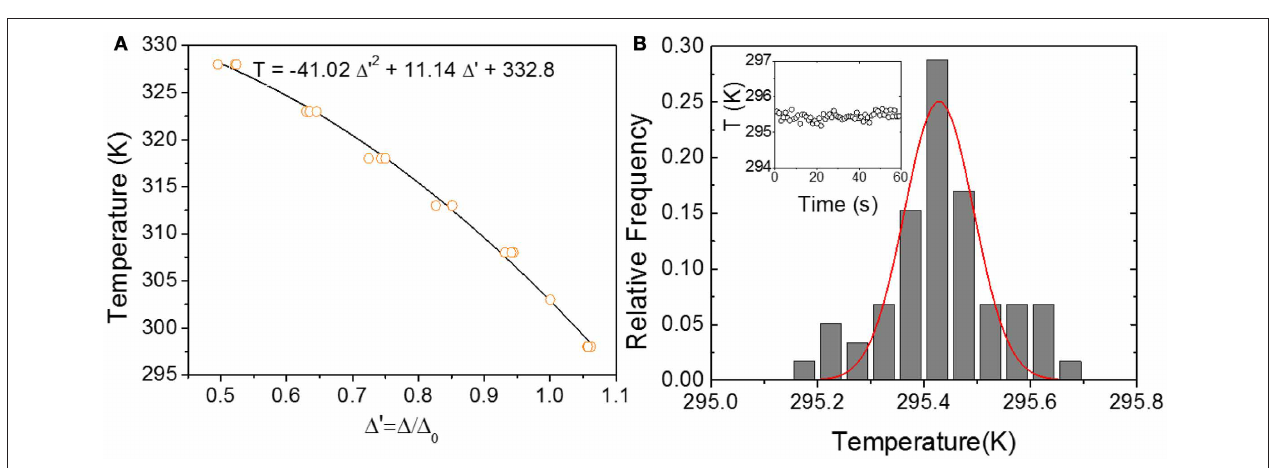
degree polynomial fit presented in the Figure ( r 2 > 0 . 995) is the local calibration curve. (B) Relative frequency of the UET–1.3 temperature read during 60s in the absence of current in the heating circuit (inset). The distribution of temperature (vertical bars) was fitted to a Gaussian (solid line) resulting in a maximum at 295.4K and a full- width-at-half-maximum of